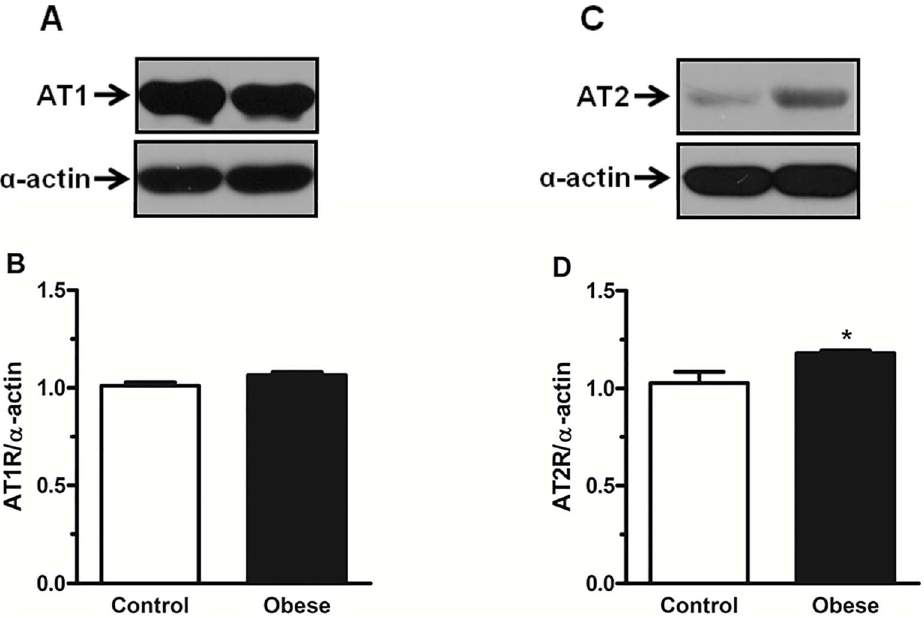
Figure 5. Effect of obesity on angiotensin II receptors protein expression in mesenteric arteries. Panels show densitometric analysis of the Western blots for AT1 and AT2 protein expression in endothelium intact mesenteric arteries from control and monosodium glutamate-induced obese rats. In A and C , Western blots for AT1 and AT2 receptors, respectively. Results were normalized to a -actin expression and expressed as units of change from the control. Data are expressed as mean 6 SEM. *, P , 0.05 vs. Control. N= 5/group.